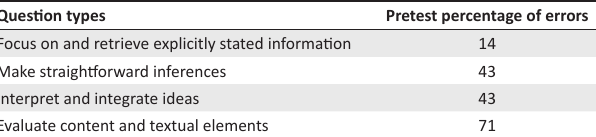
TABLE 2: Results of the pretests. Question